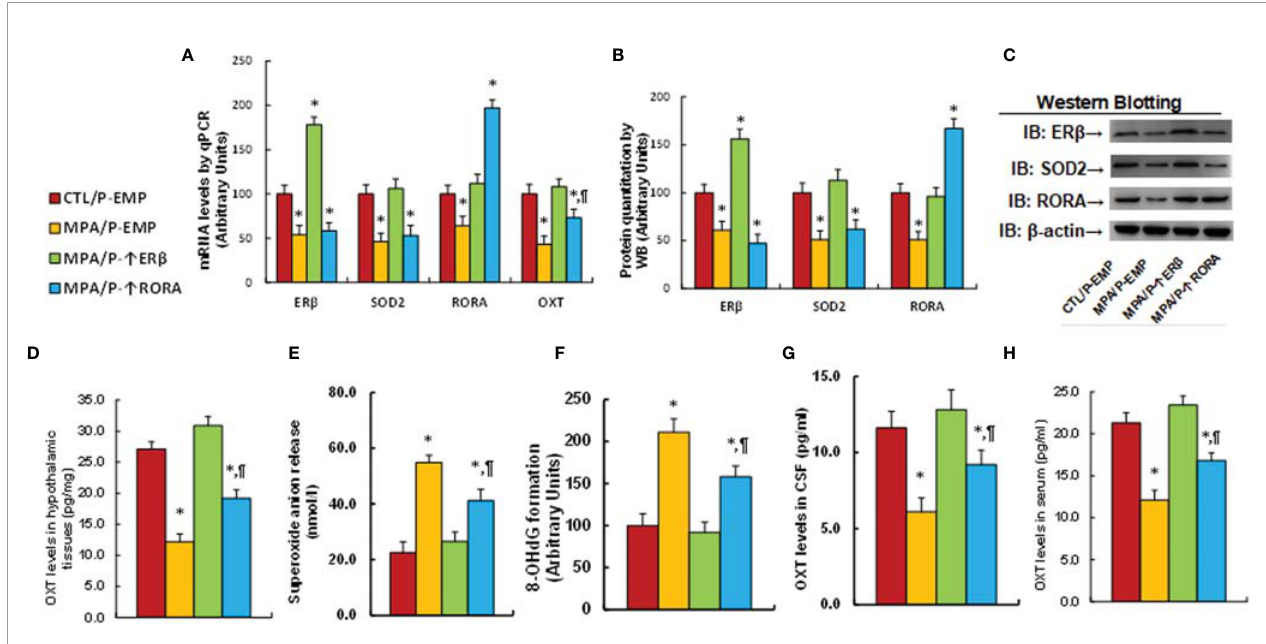
FIGURE 5 | Postnatal ER b expression completely, while postnatal RORA expression partly, reverses prenatal MPA exposure-mediated OXT suppression and oxidative stress in offspring. The pregnant dams were treated with either control (CTL) or MPA, and the subsequent offspring received either empty (EMP), ER b ( ↑ ER b ) or RORA ( ↑ RORA) lentivirus, and the offspring were then sacri fi ced for biological assays. (A – F) The hypothalamic tissues from PVN area were isolated for biological assays: (A) mRNA levels, n=4. (B) Protein quantitation, n=5. (C) Representative western blots for (B) . (D) OXT levels in hypothalamic tissues, n=5. (E) Superoxide anion release, n=5. (F) 8-OHdG generation, n=5. (G) OXT levels in CSF, n=5. (H) OXT levels in serum, n=5. * P < 0.05, vs. CTL/P-EMP group; ¶ P < 0.05, vs. MPA/P-EMP group. Data were expressed as mean ±